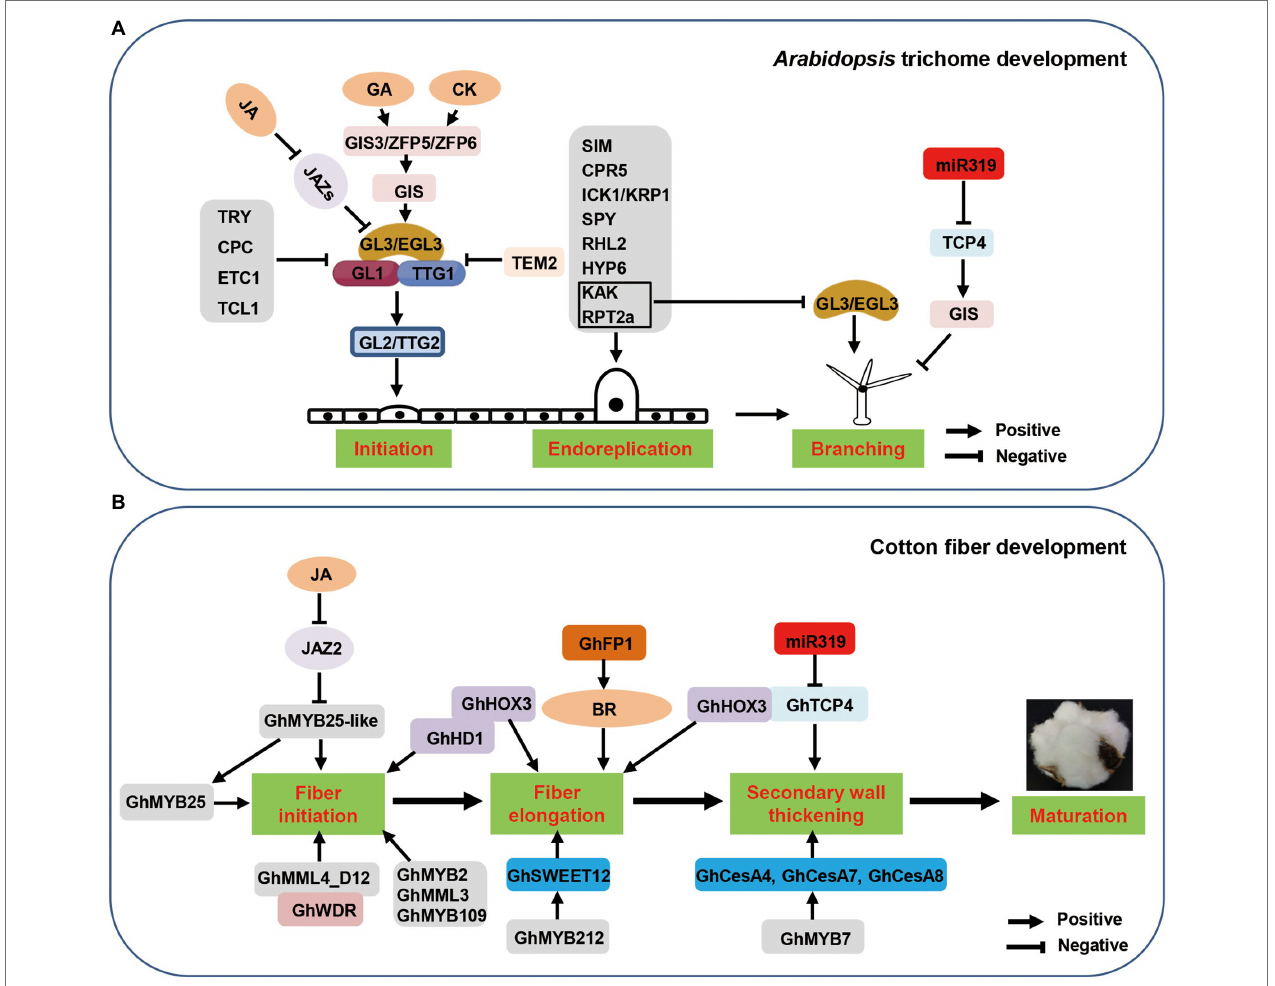
FIGURE 1 | Core regulators controlling Arabidopsis trichome development and cotton fiber development. (A) Key regulators are involved in Arabidopsis trichome development. GL1-GL3/EGL3-TTG1 is the core complex to regulate Arabidopsis trichome initiation, which is needed for the activation of GL2/TTG2. C2H2 zinc finger proteins GIS3, ZFP5, and ZFP6 that regulate trichome initiation through GA and CK signalling (Sun et al., 2015). GL2 function partially redundant with TTG2 , downstream of the GL1-GL3/EGL3-TTG1 in trichome initiation. Single-repeat MYBs TRY, CPC, ETC1, and TCL1 prevent the formation of GL1-GL3/EGL3-TTG1 complex. TEM2 significantly represses the expression GL1 and EGL3 to inhibit trichome development. Some regulators affect trichome development by endoreduplication pathway. In addition, KAK and RPT2a inhibit the expression of GL3/EGL3 causing reduced trichome branching. In addition to regulating trichome initiation, GL3/EGL3 is also involved in trichome branching. TCP4 suppresses trichome branching by direct transcriptional activation of GIS (Wang et al., 2019b). (B) Key regulators are involved in cotton fiber development. MYB, bHLH, and HD-ZIP TFs are important regulators in cotton fiber development. GhMYB25 and GhMYB25-like have been identified as regulators of fiber initiation, and GhJAZ2 negatively regulates fiber initiation by interacting with GhMYB25-like. GhMML4 is known to regulate the fiber development by binding with GhWDR. GhHD1 regulates fiber initiation, while GhHOX3 regulates fiber elongation. GhHOX3 interacts with GhHD1, enhancing transcriptional activity of GhHOX3. In fiber elongation stage, GhMYB212 directly controls expression of sucrose transporter gene GhSWEET12 (Wang et al., 2019b). GhFP1 directly binds to GhDWF4 and GhCPD promoters to activate BR biosynthesis and signaling to regulate fiber elongation. GhMYB7 directly regulates fiber cellulose synthesis by binding to three different cis-elements in the GhCesA4 , GhCesA7 , and GhCesA8 promoters. GhTCP4 maintains the balance between cotton fiber cell elongation and cell wall synthesis by interacting